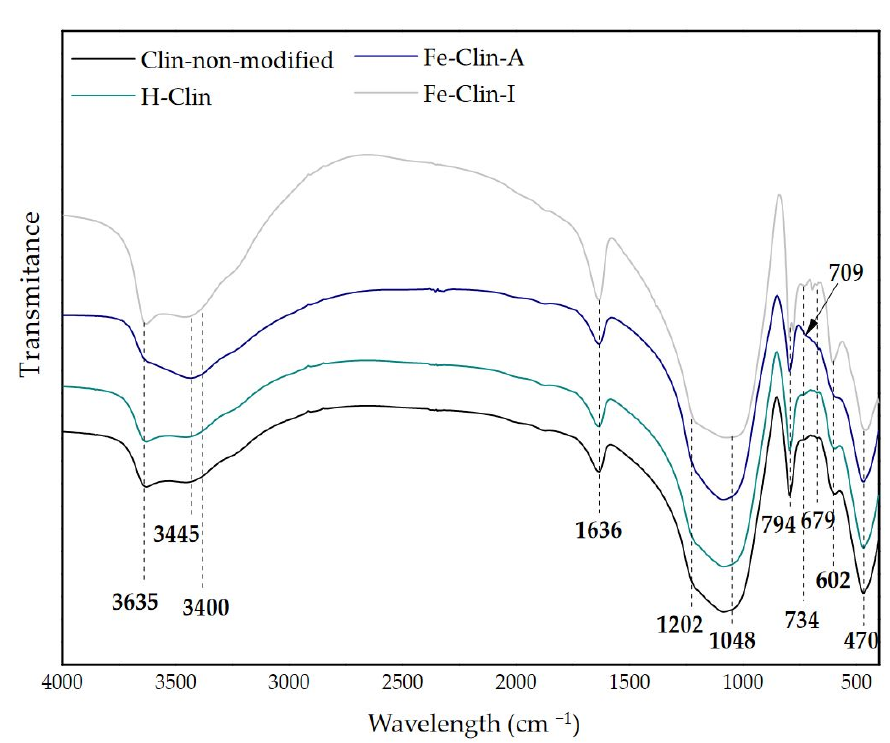
Figure 3. Fourier-Transform Infrared spectroscopy (FT-IR) spectra of non-modified clinoptilolite, H-Clin, Fe-Clin-A, and Fe-Clin-I.